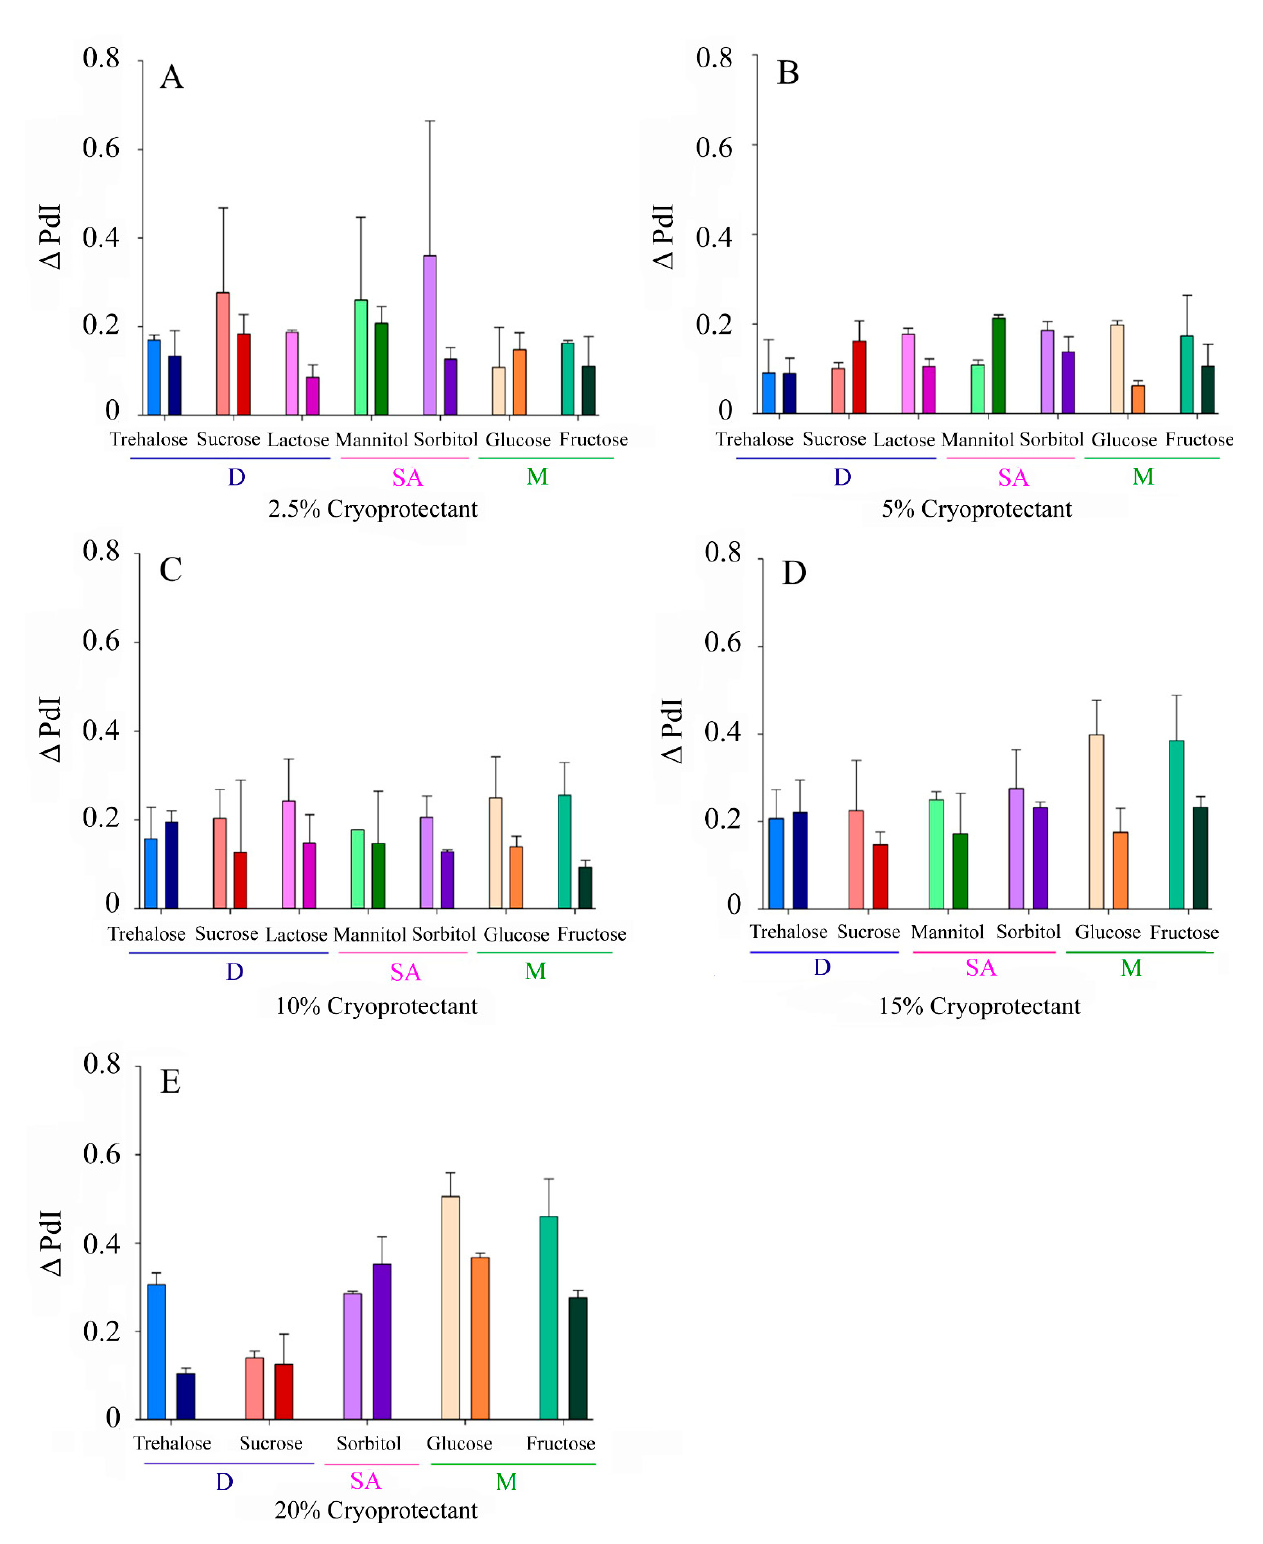
Figure 3. Increase in the polydispersity index of the NLCs ( Δ PdI) after lyophilization with different CPs at variable concentrations: ( A ) 2.5% w/v , ( B ) 5% w/v , ( C ) 10% w/v , ( D ), 15% ( w/v ), ( E ) 20% w/v . Light colours correspond to slow freezing processes and dark colours to fast freezing processes. The CPs are grouped according to their type into disaccharides (D), sugar alcohols (SA), and monosaccharides (M).